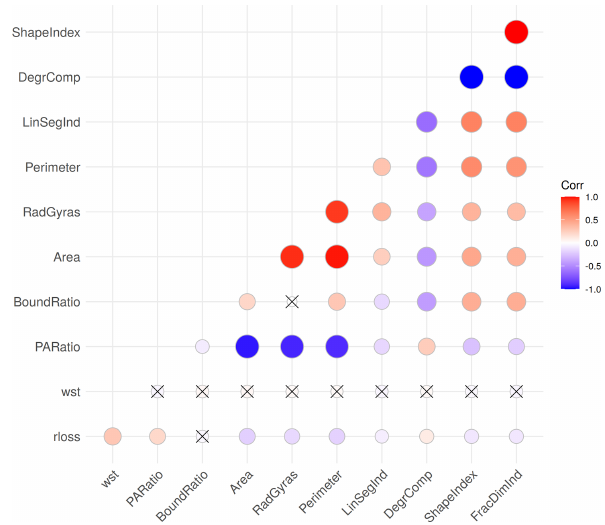
Figure 4. Spearman’s correlation of model variables (significance level of 1%); non-significant correlations are crossed